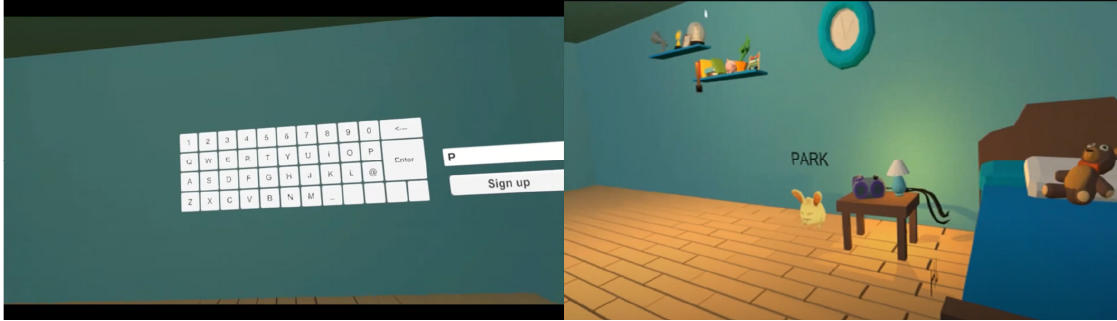
Figure 6. The main house scene with user login interaction (left), main house interior with the PARK user character (right).